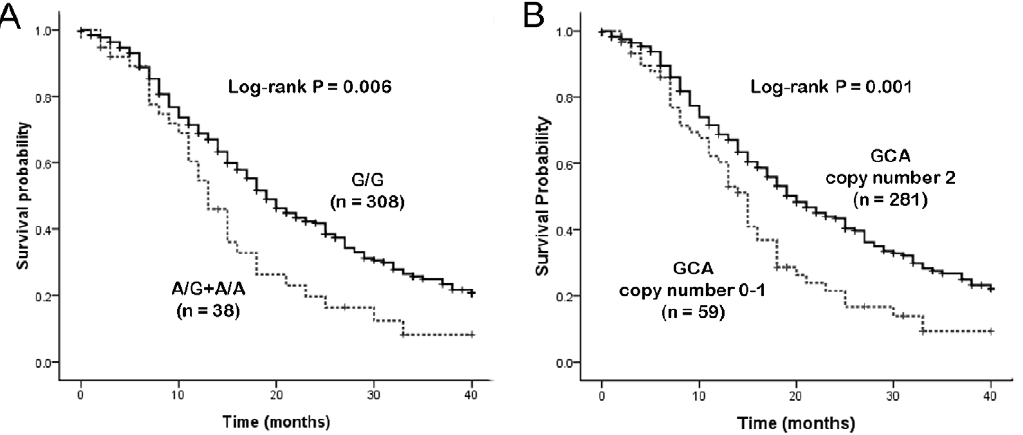
Figure 1. Kaplan–Meier curve of overall survival according to (A) XPDAsp 312 Asn polymorphism and (B) XPD haplotype. doi:10.1371/journal.pone.0033200.g001 PLoS ONE |